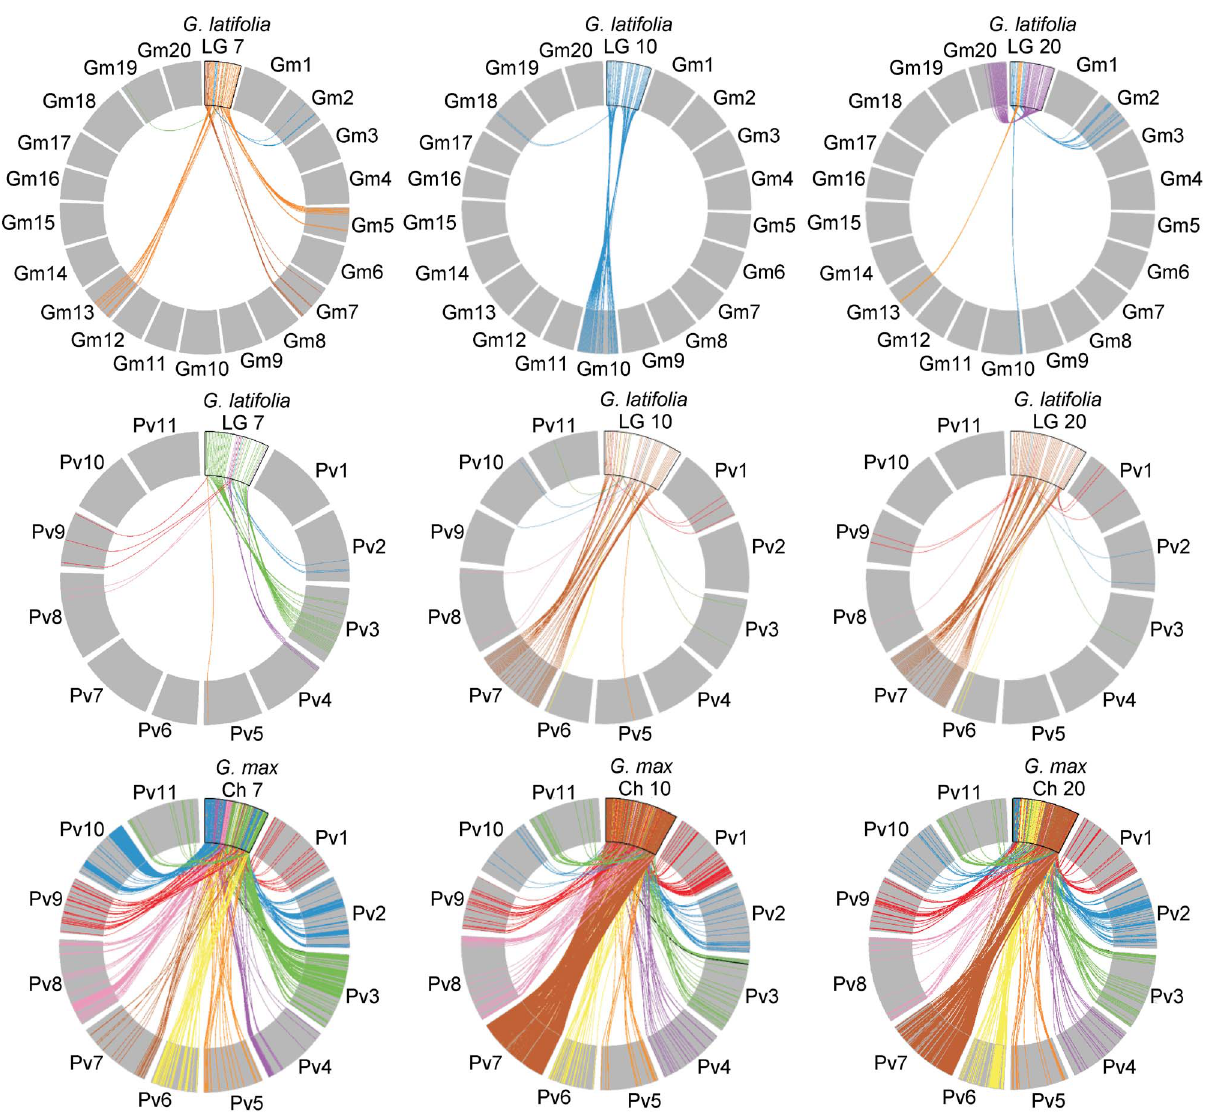
Figure 4. Comparison of synteny of individual Glycinelatifolia linkage groups 7, 10 and 20 with G.max and Phaseolusvulgaris chromosomes. Glycine latifolia linkage groups (A & B) and G. max chromosomes (C) are placed at the top of each circle with colored lines connecting positions of G. latifolia SNP markers (A & B) or G.max gene model (C) sequences to positions in G. max (Gm01 – Gm20) or P. vulgaris (PV01 – PV11) chromosomes, represented by gray boxes. Glycine latifolia linkage groups 7 and 20 appeared to have larger syntenic blocks with single P. vulgaris chromosomes than G. max chromosomes. Both G. latifolia linkage groups 10 and 20 showed large blocks of synteny with P. vulgaris chromosome 7, as did G. max chromosome 10. Synteny maps were constructed using MizBee